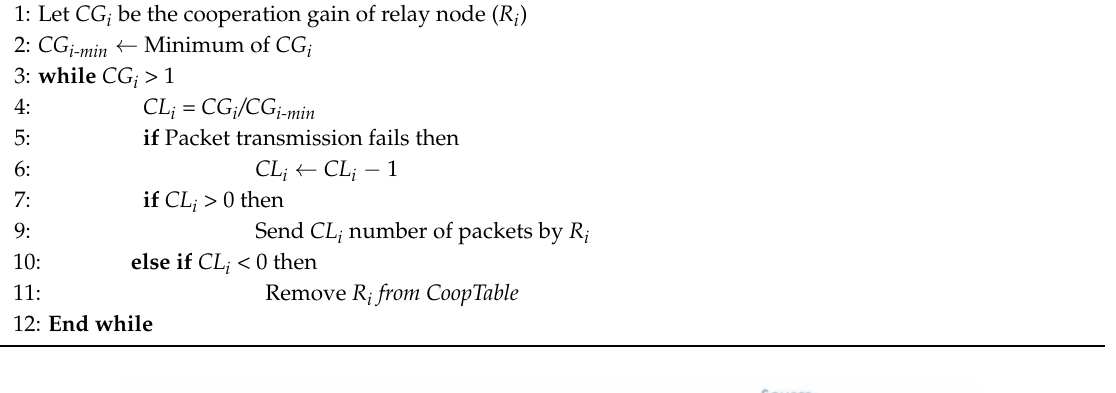
Algorithm 1: Algorithm of relay selection in the FC-MAC protocol